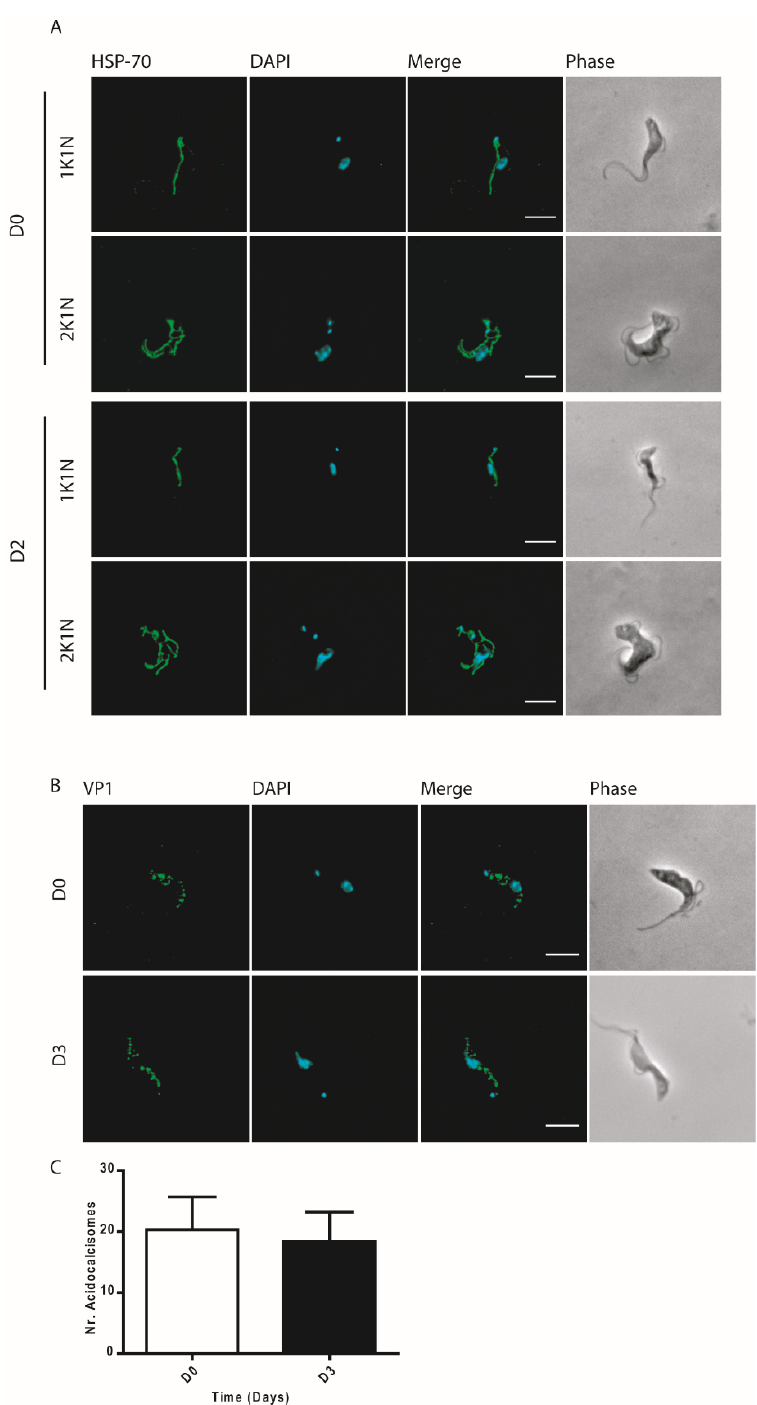
FIGURE 3: Effect of TCTP depletion on mitochondria and acidocalcisomes in BSF cells. (A) Immunofluorescence images of non- induced (D0) and induced at day two (D2) bloodstream cells stained for mitochondria (HSP-70, green). (B) Morphology of acidocal- cisomes following downregulation of TCTP in BSF. Non-induced (D0) and induced at day three (D3) BSF trypanosomes were stained for acidocalcisome with the marker VP1 (green). Nuclear DNA and kDNA were detected with DAPI (cyan). Phase contrast images (grey) show cell morphology. Cell morphology is shown by phase contrast images (PH, grey). (C) Histograms showing the mean number of acidocalcisomes per cell in D0 and D3 cells (n = 13). Scale bars: 5